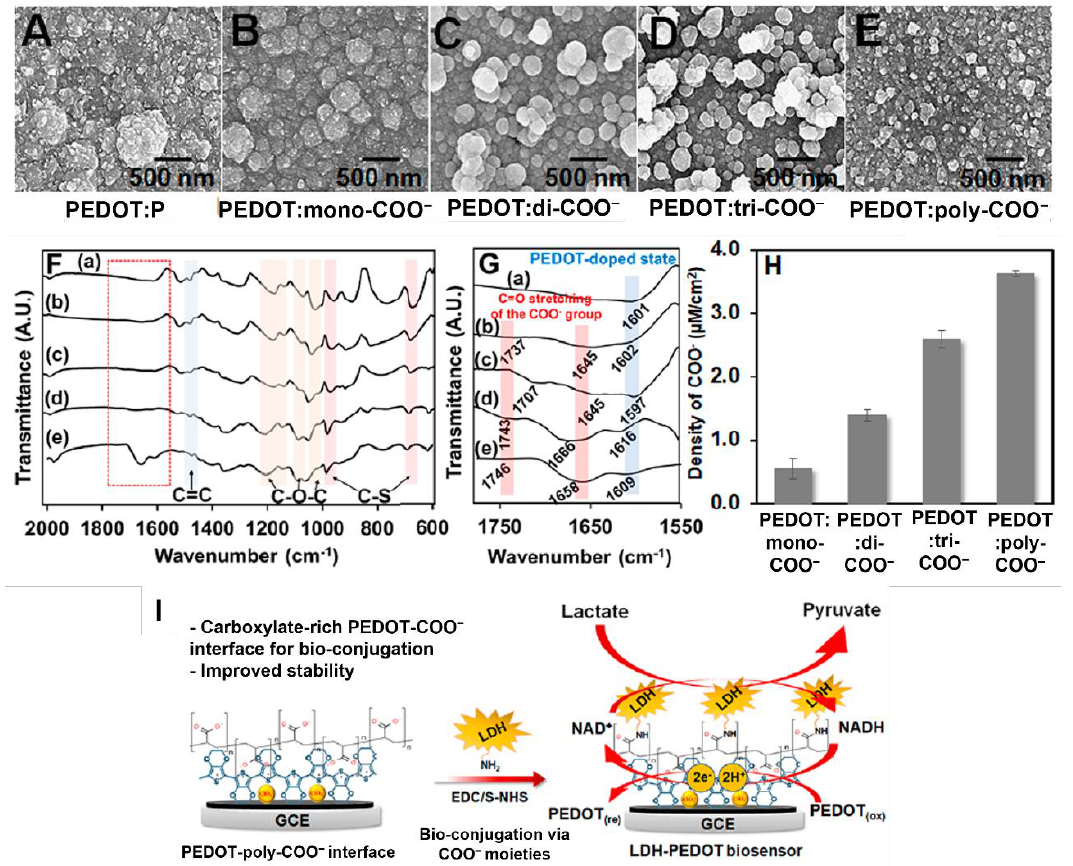
Figure 8. SEM images of different PEDOT:COO − films (PEDOT:P is for PEDOT without COO − ). The scale bar is 500 nm ( A – E ). FTIR spectra in the range 2000 − 600 cm − 1 ( F ) and 1750 − 1550 cm − 1 ( G ) for (a) PEDOT:P, (b) PEDOT:mono-COO − , (c) PEDOT:di-COO − , (d) PEDOT:tri-COO − , and (e) PEDOT:poly-COO − . Density of carboxylate groups of different PEDOT:COO − films measured by the TBO assay ( H ). LDH anchoring and lactate biosensing mechanism at the LDH-PEDOT interface ( I ). Adapted with permission from reference [4]. Copyright 2020 American Chemical Society.